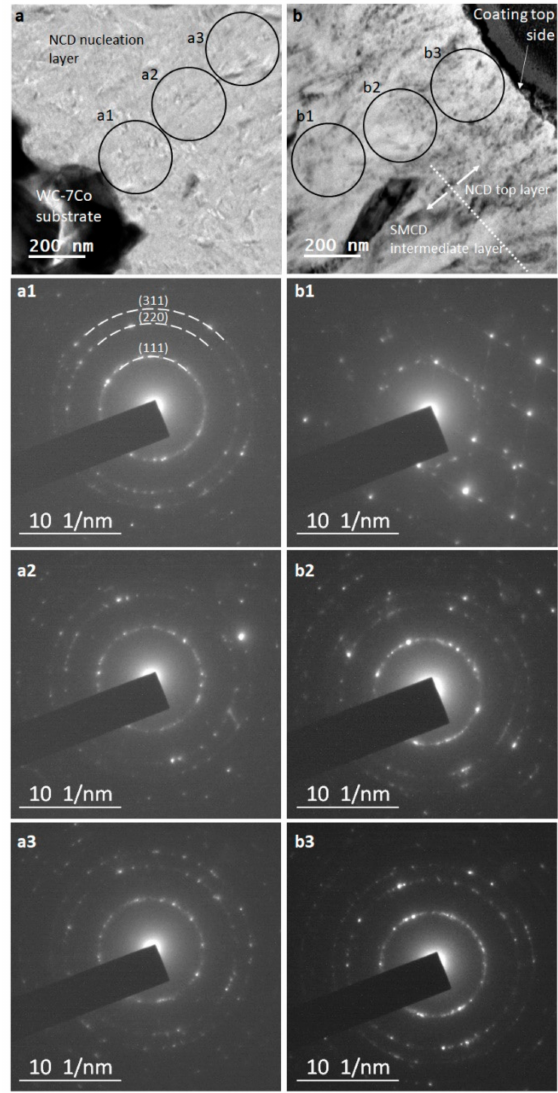
Figure 4. Selected area diffraction patterns of the multilayer diamond coating recording across its thickness in the following order from the substrate side ( a ) to the surface side ( b ): a1, a2, a3, b1, b2, b3.